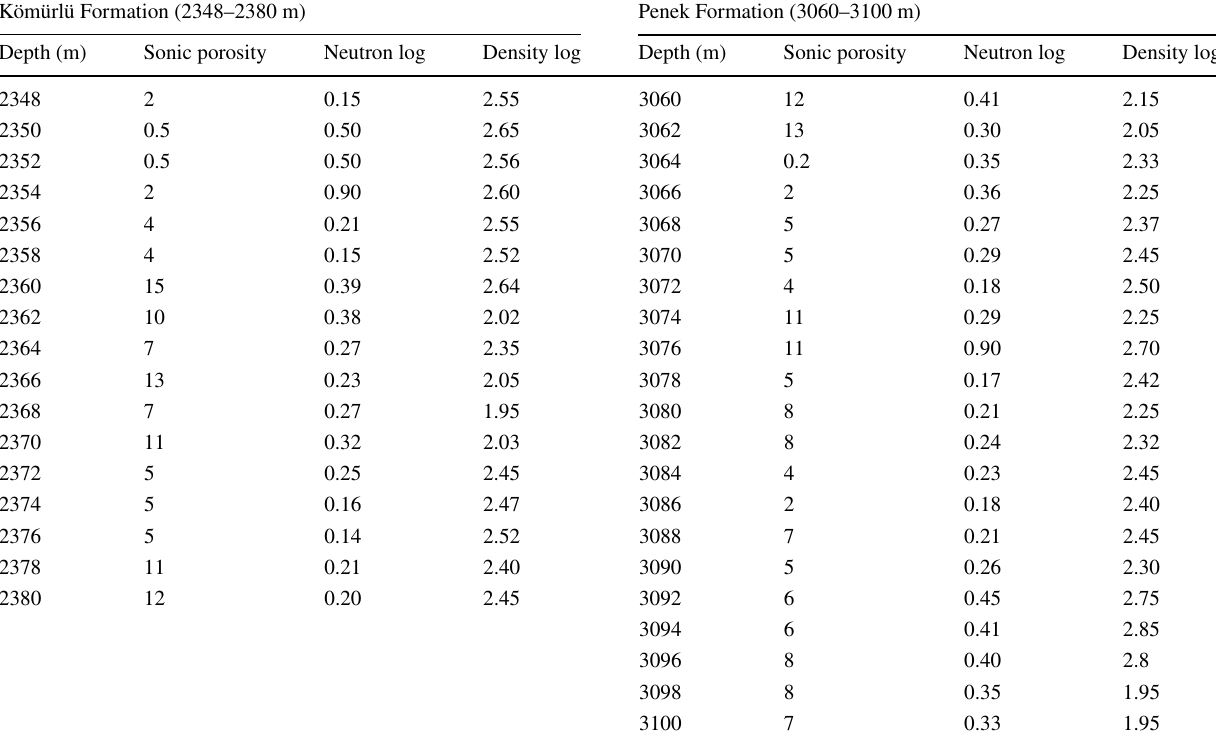
Table 2 Sonic, neutron log, and density log porosity values of the Kömürlü and Penek Formation sandstones, Aşkale sub-basin Kömürlü Formation (2348–2380 m)